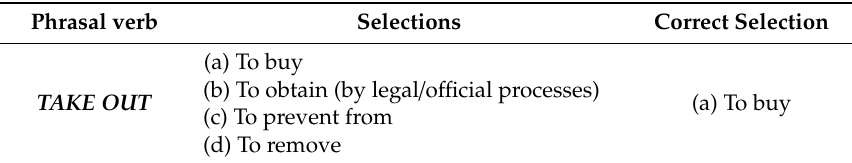
Table 5. Take out interpretations.